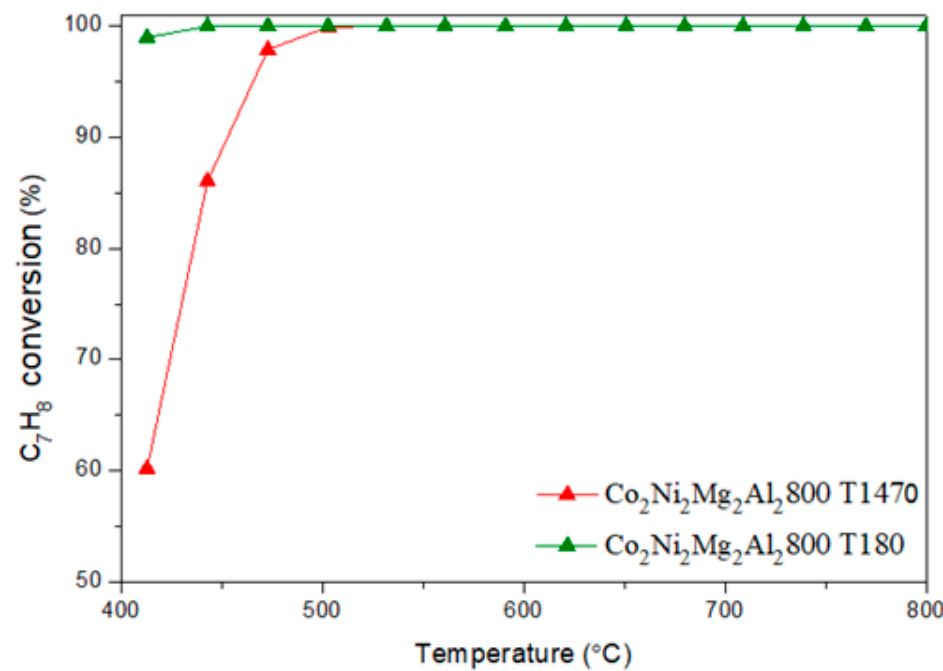
Figure 12. Conversion of toluene in DRM, followed by MS, versus reaction temperature on the catalyst